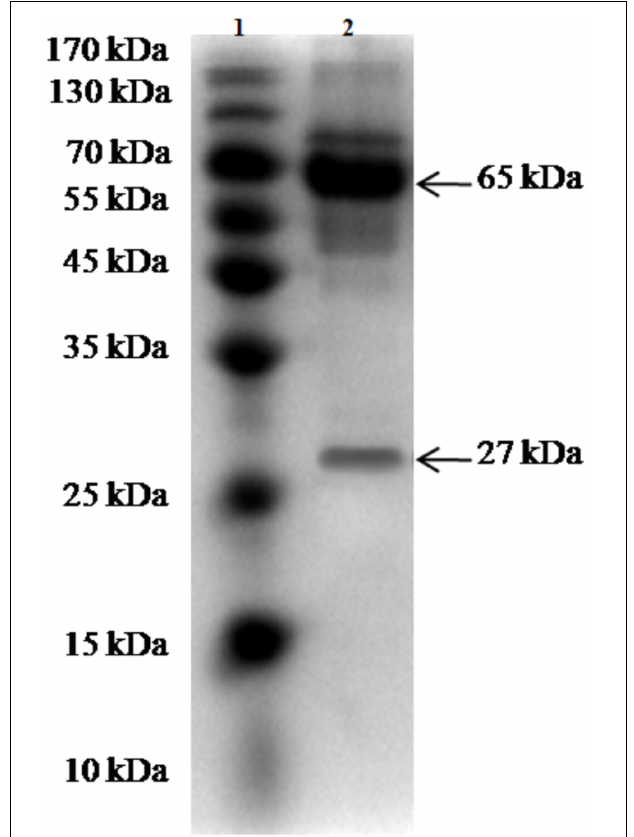
FIGURE 2 | SDS-PAGE of the purified IgY for CSBV. Lane 1 : Protein marker and Lane 2 : Purity of